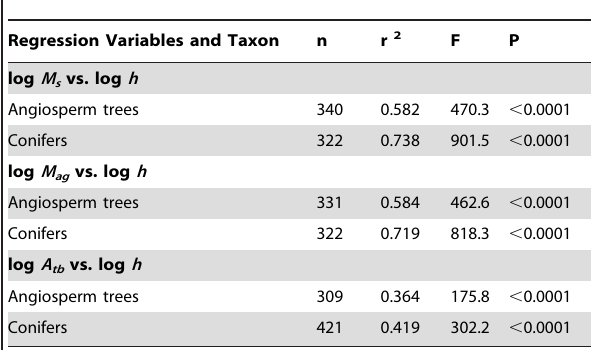
Table 4. Summary of ordinary least squares regression of log 10 -transformed empirical data for H mean , total stem dry mass per hectare ( M s ), total above-ground dry mass per hectare ( M ag ), and total stem basal area per hectare ( A tb ) across conifer and angiosperm dominated forested